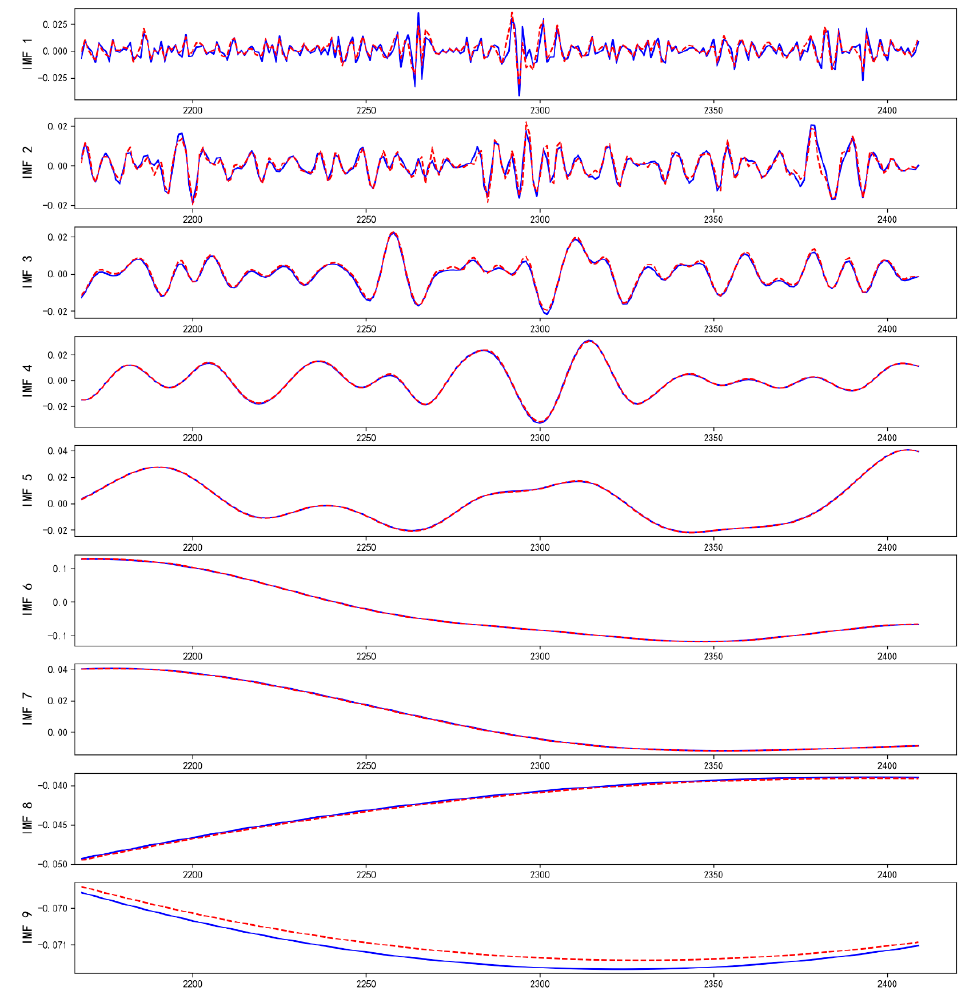
Figure 7. Integration of forecast results of di ff erent IMF sequences.